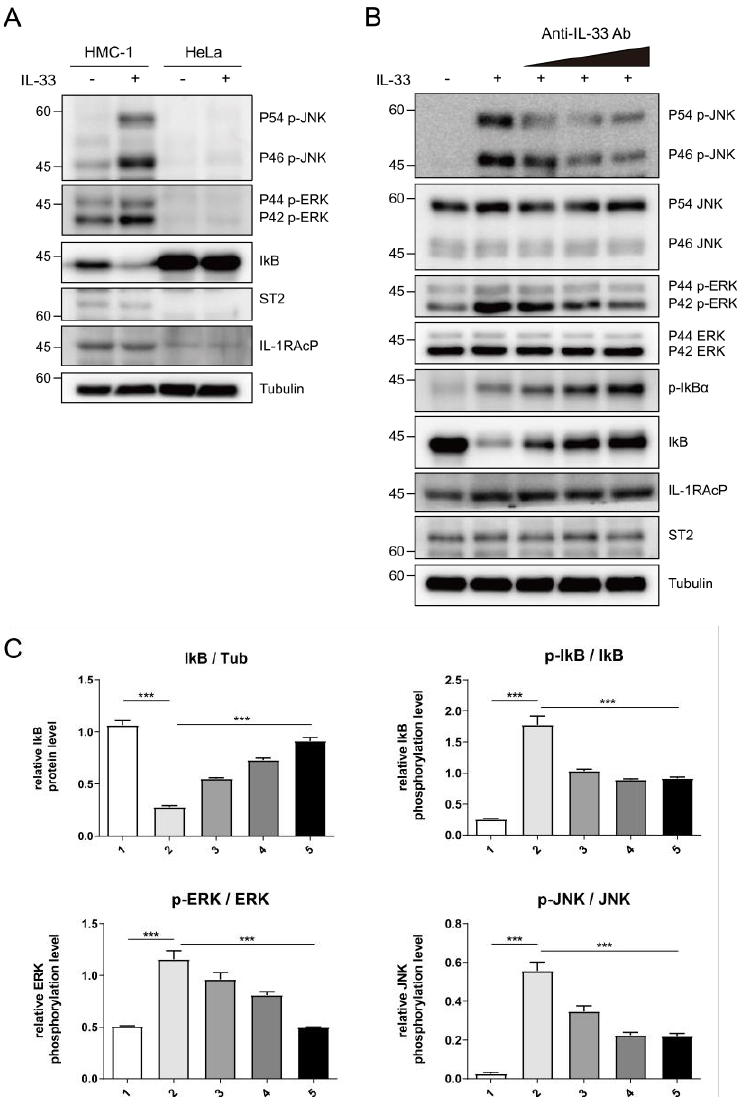
Figure 4. Intervention of IL-33 / ST2 signaling axis by C2_2E12 antibody. ( A ) IL-33-mediated activation of nuclear factor κ B (NF- κ B) signaling in human mast cells (HMC-1) cells, but not in HeLa cells where ST2 and IL-1RAcP were not expressed. HMC-1 and HeLa cells were stimulated with mock or human IL-33 (1 ng · mL − 1 , 8 min), and cell lysates were analyzed by immunoblotting with the indicated antibodies. ( B ) The inhibition of IL-33-induced NF- κ B signaling by C2_2E12 antibody in a dose-dependent manner. HMC-1 cells were treated with IL-33 alone or IL-33 pre-incubated with the increasing amounts of C2_2E12 antibody. Cell lysates were analyzed by immunoblotting with the indicated antibodies. IL-33 (1 ng · mL − 1 ) was pre-incubated with increasing amounts of the C2_2E12 antibody (0.1, 0.5, and 2.0 ng · mL − 1 in lanes 3, 4, and 5, respectively) for 15 min and treated to HMC-1 cells for 8 min. ( C ) Quantification of protein levels shown in ( B ). Band intensities in immunoblots were quantified using ImageJ. Data are expressed as the mean ± SEM. The statistical significance of di ff erences was analyzed by one-way analysis of variance (ANOVA) followed by Bonferroni’s multiple comparison test (*** p < 0.001 compared to the indicated points; n = 3).